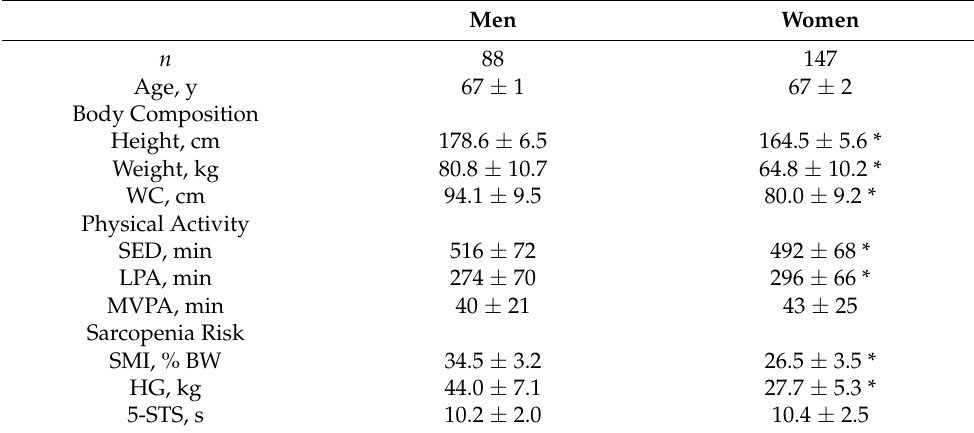
Table 1. General characteristics of the study population.